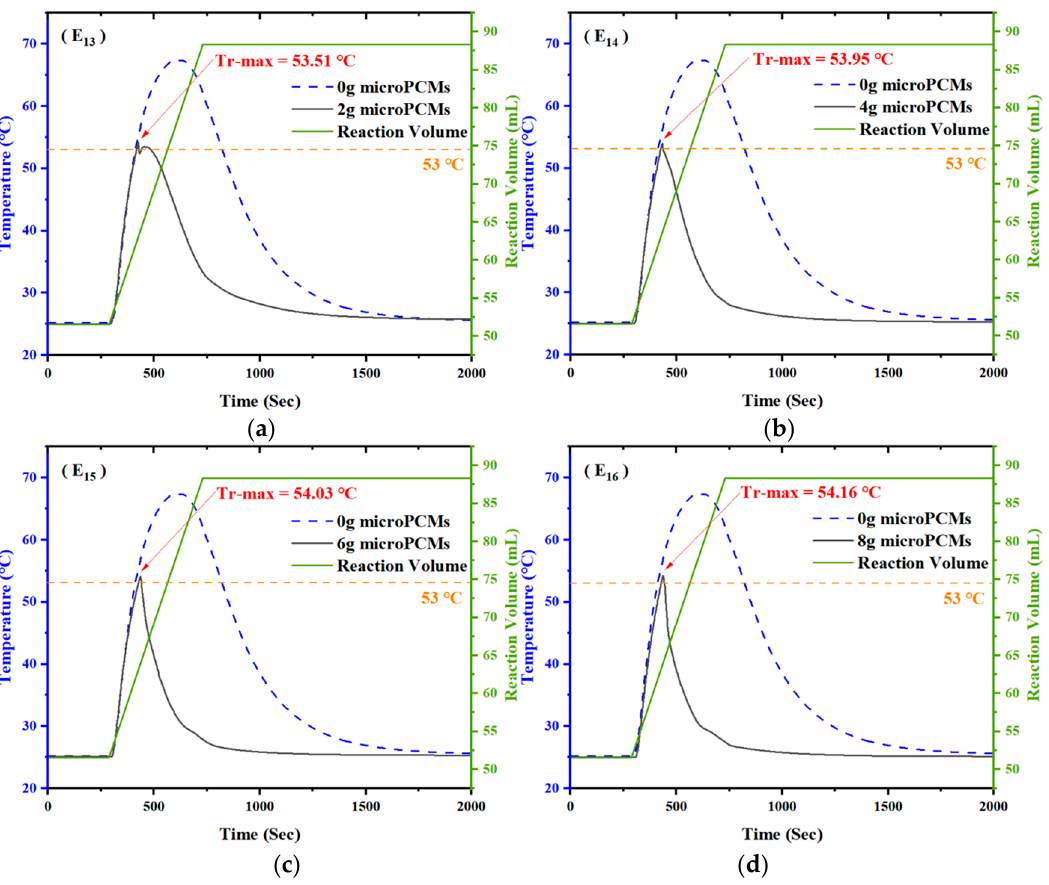
Figure 14. Experimental results with addition amount of ( a ) 2 g, ( b ) 4 g, ( c ) 6 g, ( d ) 8 g microPCMs at the temperature of 53